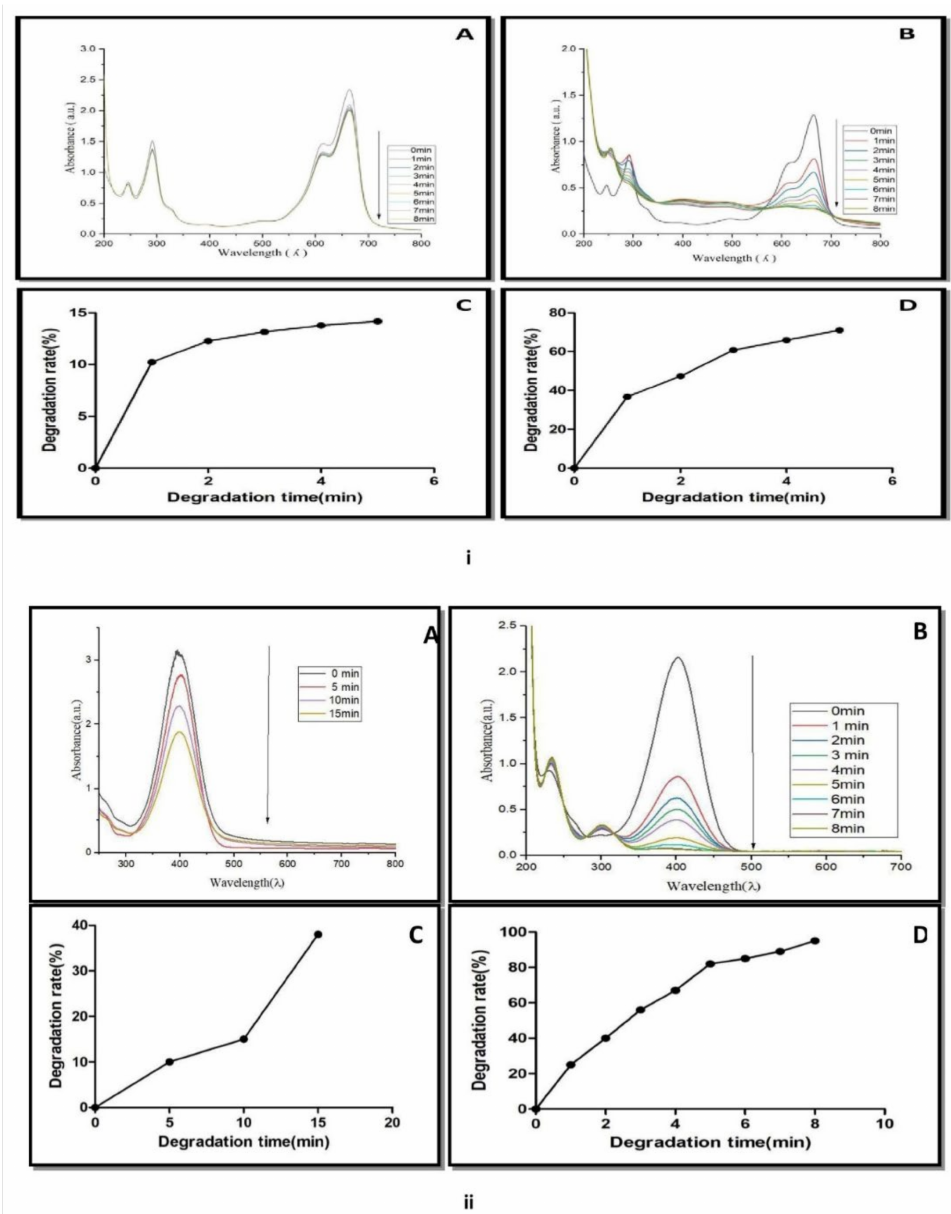
Figure 9. ( i ) UV-Vis spectra of methylene blue reduction in presence of ( A ) NaBH 4 , ( B ) NaBH 4 + green biosynthesized AgNPs. ( C ) Catalytic degradation (%) of methylene blue in the presence of NaBH 4 . ( D ) Catalytic degradation (%) with NaBH 4 + AgNPs. ( ii ) UV-Vis spectra of 4-nitro phenol reduction in the presence of ( A ) NaBH 4 , ( B ) NaBH 4 + green biosynthesized AgNPs, ( C ) catalytic degradation (%) with NaBH 4 . ( D ) Catalytic degradation (%) with NaBH 4 +